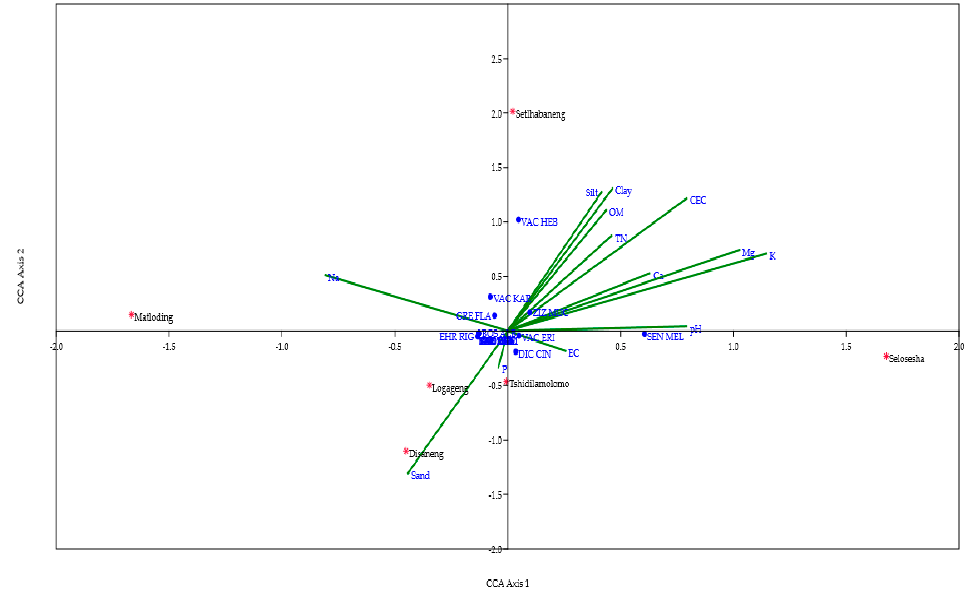
Figure 4. Canonical correspondence analysis (CCA) triplot ordination showing ordination of woody